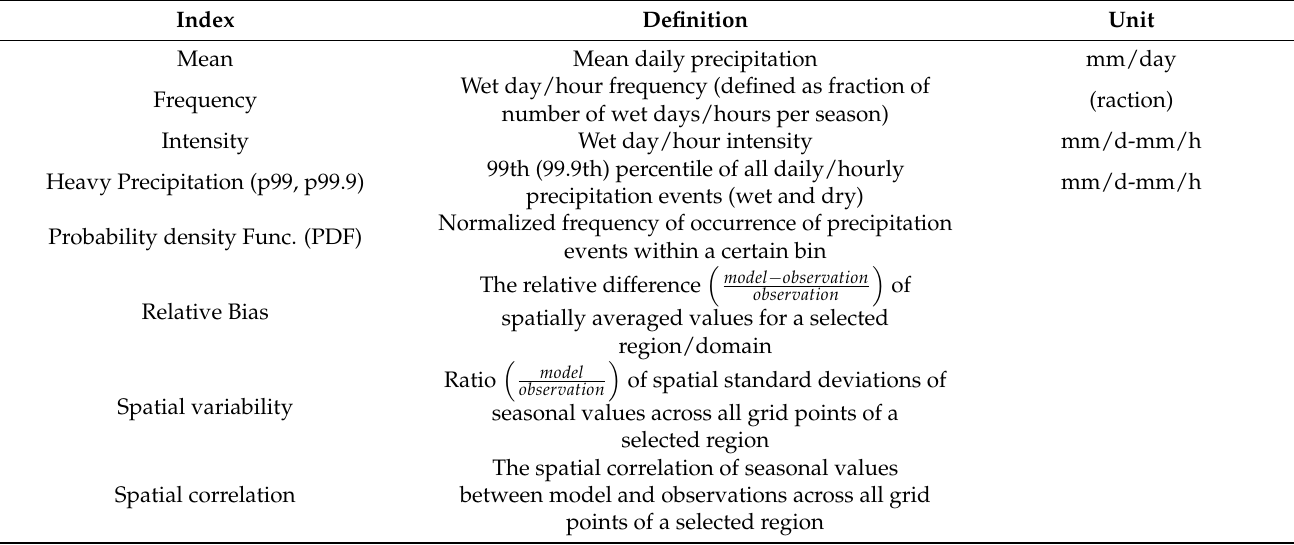
Table 2. Statistical indices analysed in this study (a wet day (hour) is a day (hour) with precipitation ≥ 1 mm ( ≥ 0.1